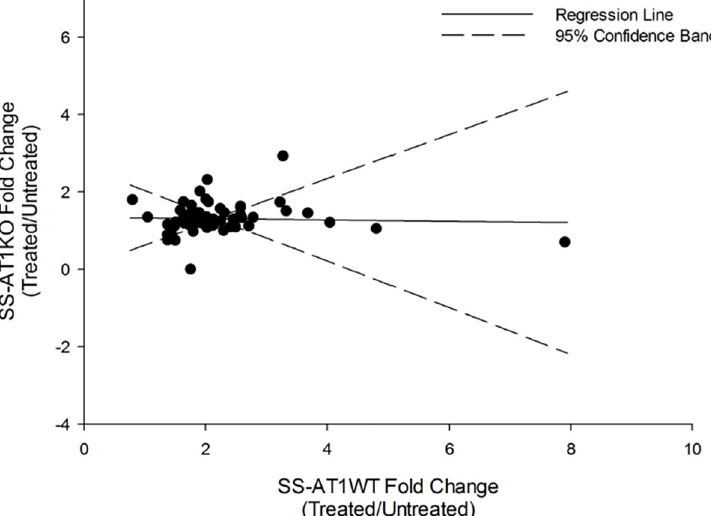
Fig 5. AT1R A contributes to the transcriptional response to Ang-(1–7). Levels of mRNA associated with angiogenesis pathways increased upon stimulation with Ang-(1–7) in Dahl salt-sensitive endothelial cells but not AT1a knockout cells. Values represent fold change in expression as detected via qPCR, with SS-AT1WT value on the x-axis and SS-AT1KO values on the y-axis (R 2 = 9.2x10 -5 ). Hypothesis testing via Deming regression showed that the slope representing the relationship between SS-AT1WT and SS-AT1KO values was different from 1 (p < 0.0005) but not different from 0 (p = 0.87).